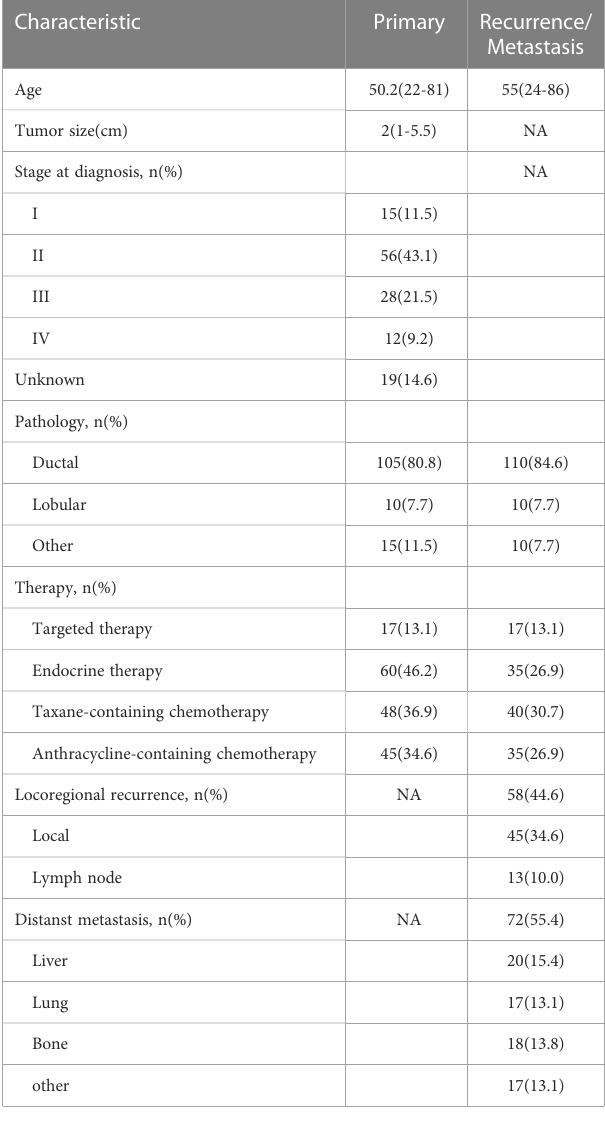
TABLE 1 Patient and tumor characteristics at primary diagnosis and recurrence/metastasis.